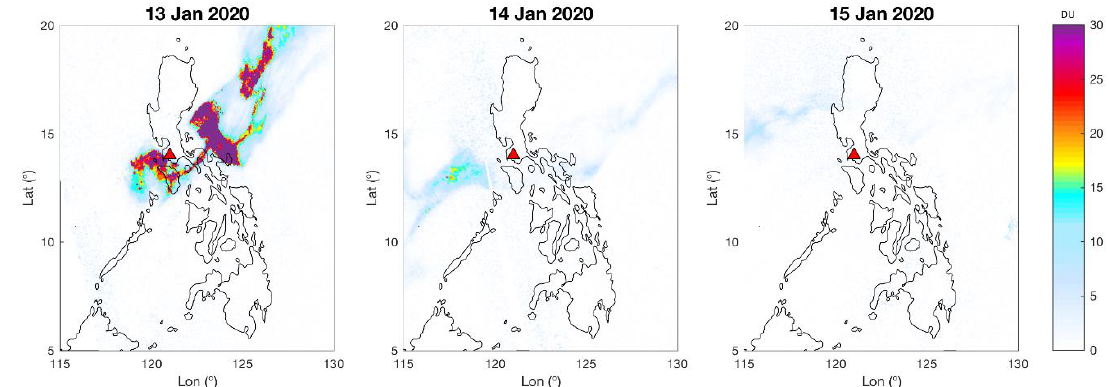
Figure 9. Spatial distribution of the total vertical column of TROPOspheric Monitoring Instrument (TROPOMI) SO 2 after the eruption of the Taal volcano observed by Sentinel-5P. The red triangle indicates the geographic location of the Taal volcano.